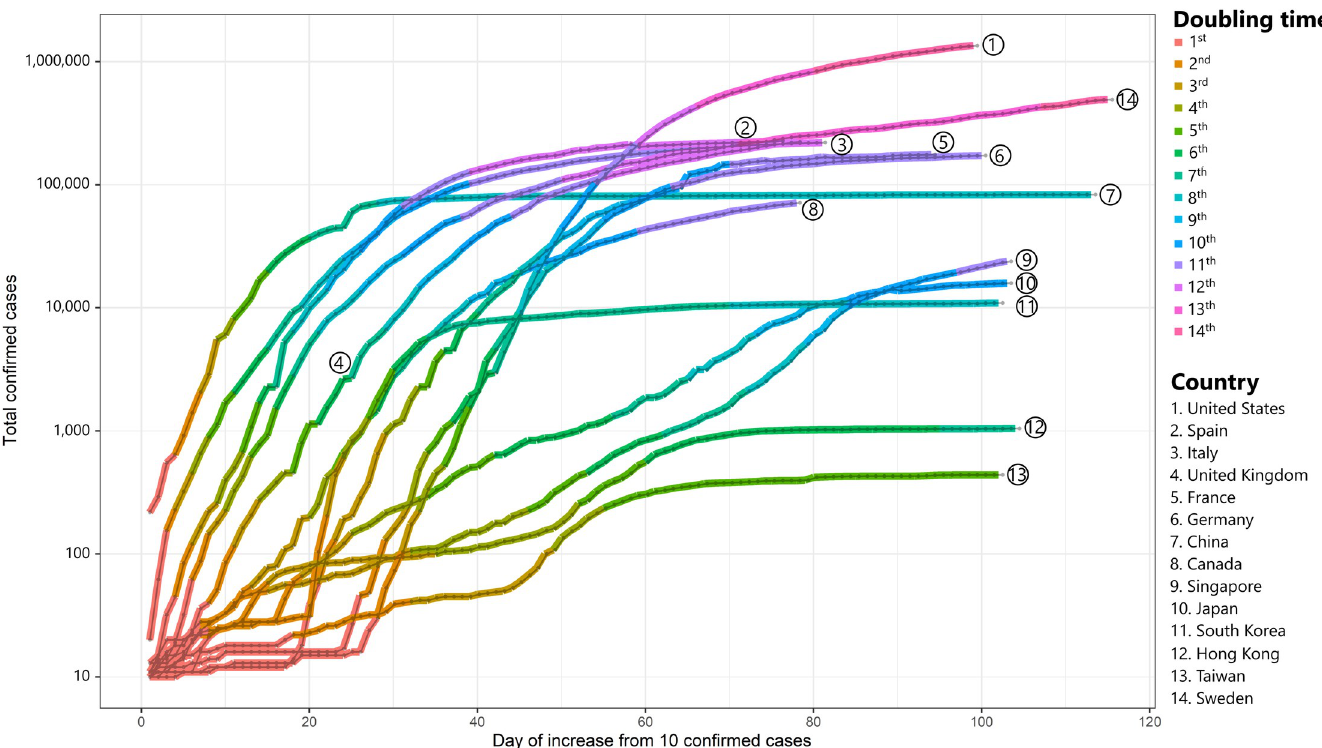
Fig 3. Doubling time